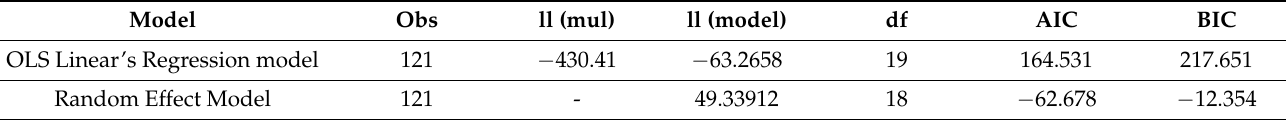
Table 4. Akaike’s information criterion and Bayesian information criterion.